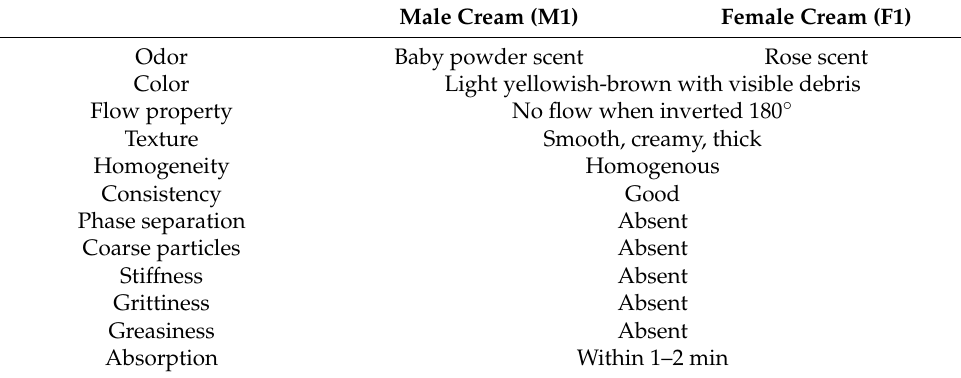
Table 3. Organoleptic characteristics of